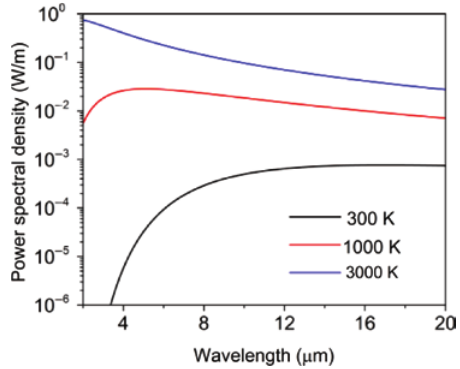
Figure 8: Power spectral density of a single-mode ideal black body emitter at various temperatures according to Eq.